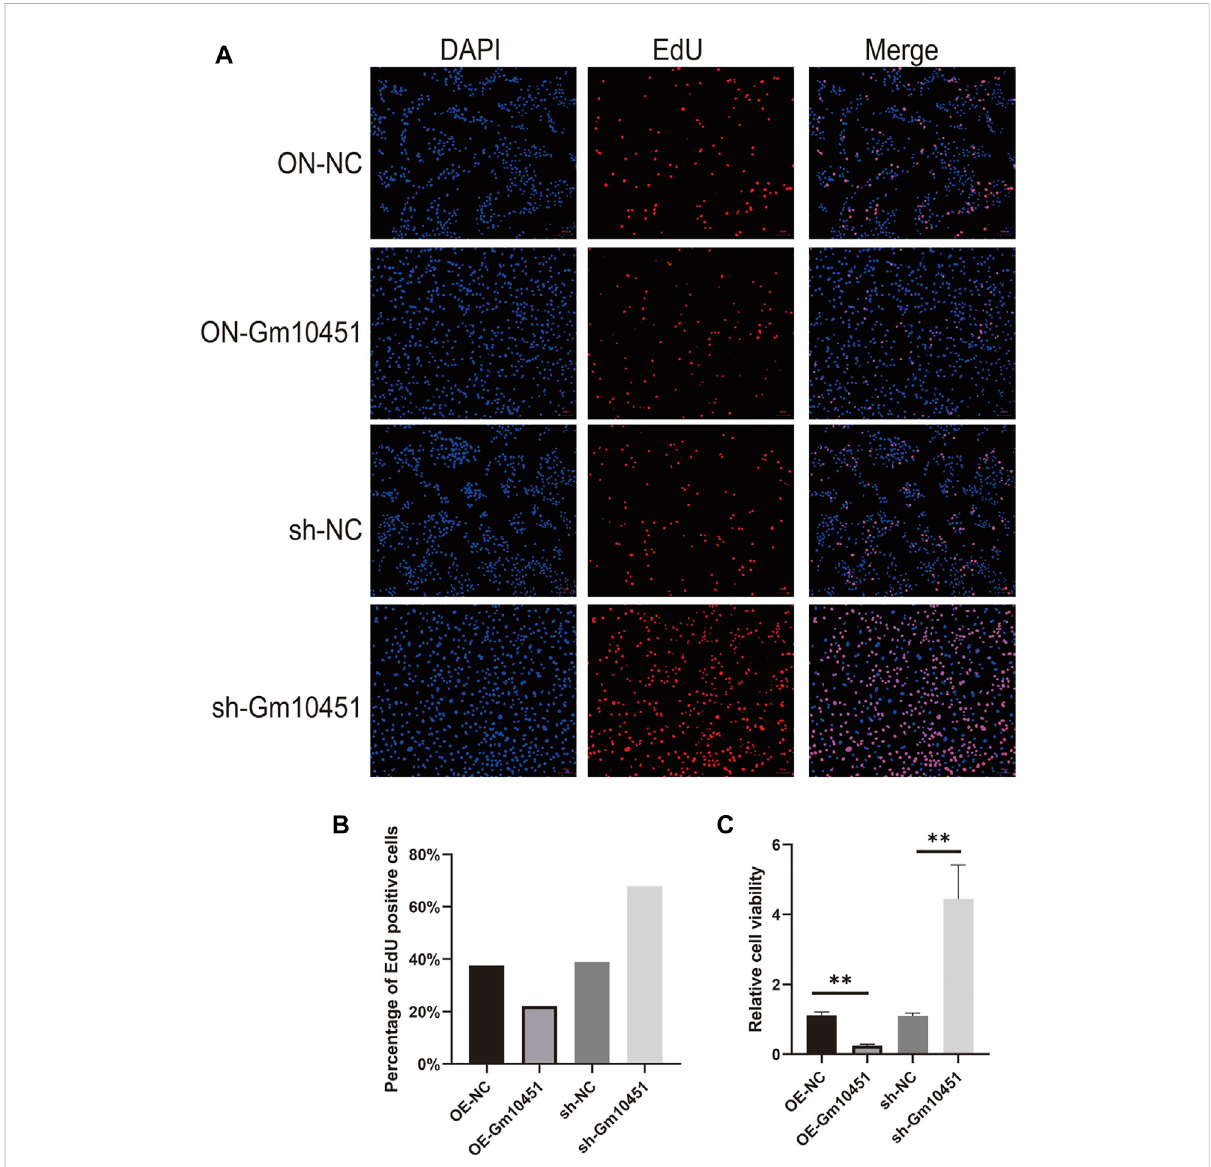
High levels of Gm10451 hindered MIN6 cell proliferation. (A,B) Assessment on MIN6 cell proliferation via Edu. (C) Assessment on MIN6 cell proliferation via MTT. N = 3. **, p <